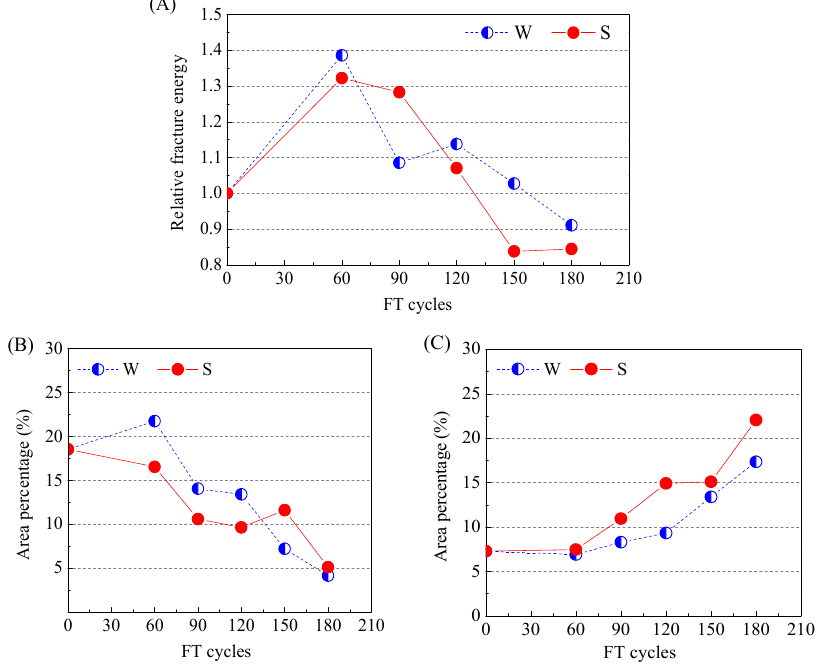
Figure 8. Evolution of fracture energy ( A ) and area percentage of aggregate splitting failure ( B ) and pulled-out failure ( C ) at different FT cycles.